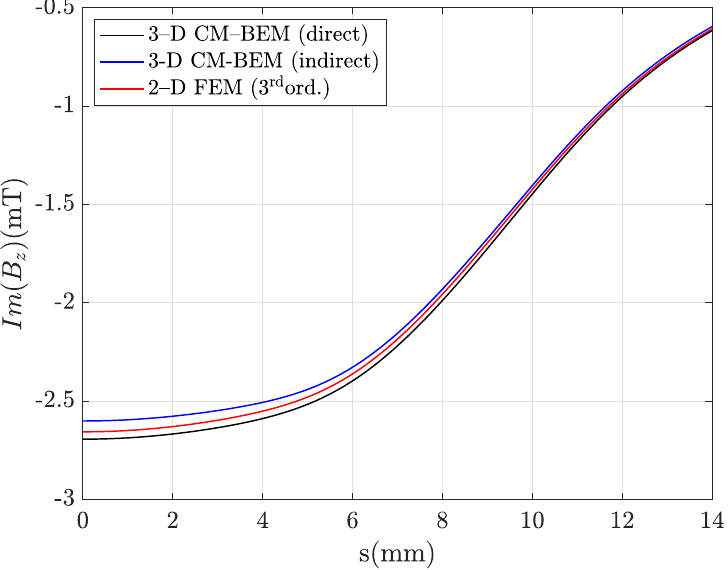
Figure 10. Imaginary part of the axial magnetic flux density component along line C-D (black line: direct formulation, blue line: indirect formulation, red line: 2D FEM, taken as a